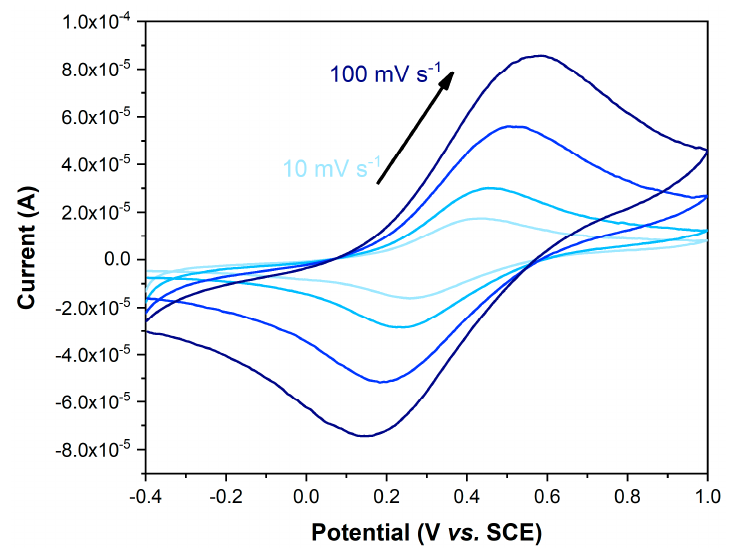
Figure 7. Cyclic voltammogram in ACN + 0.1 M TBAP of the GCE/CBP/FPOP at different scan rates of 10, 20, 50, and 100 mV s − 1 .